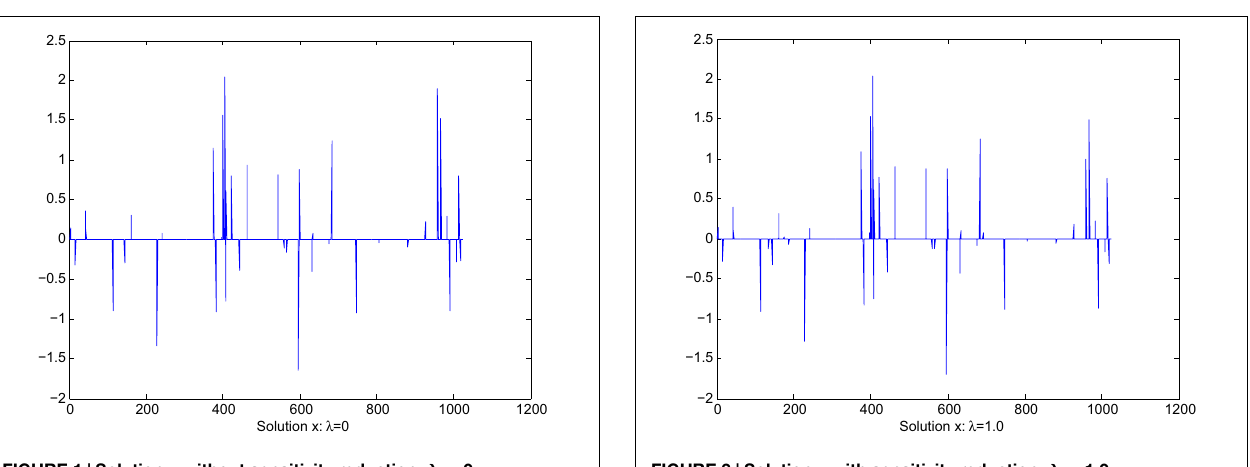
FIGURE 3 | Solution x with sensitivity reduction: (cid:21) = 1.0 .